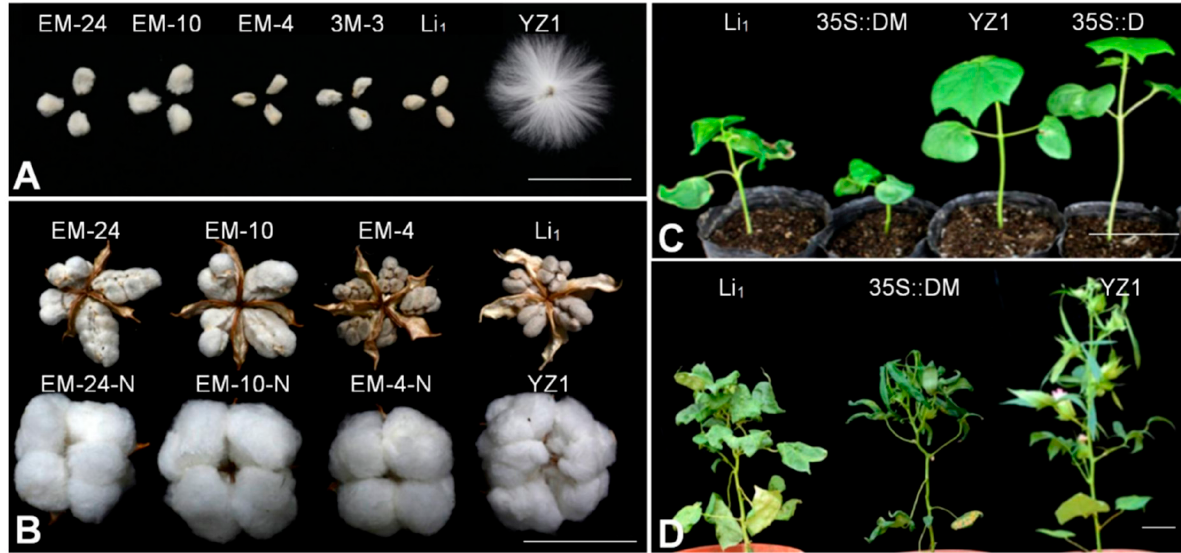
Figure 3. Phenotype of transgenic cotton. ( A ), The mature fibers of transgenic and wild-type cotton. ( B ), The mature bolls of transgenic cotton and null. ( C , D ), Phenotype of GhACT17DM transgenic cotton shows dwarf plant and crinkled leaves. 35S:DM, overexpression of GhACT17DM with CaMV35; 35S:D, overexpression of GhACT17D with CaMV35; EM24/10/4-N, the normal plant segregated from transgenic cotton. Scale bars, 5 cm.